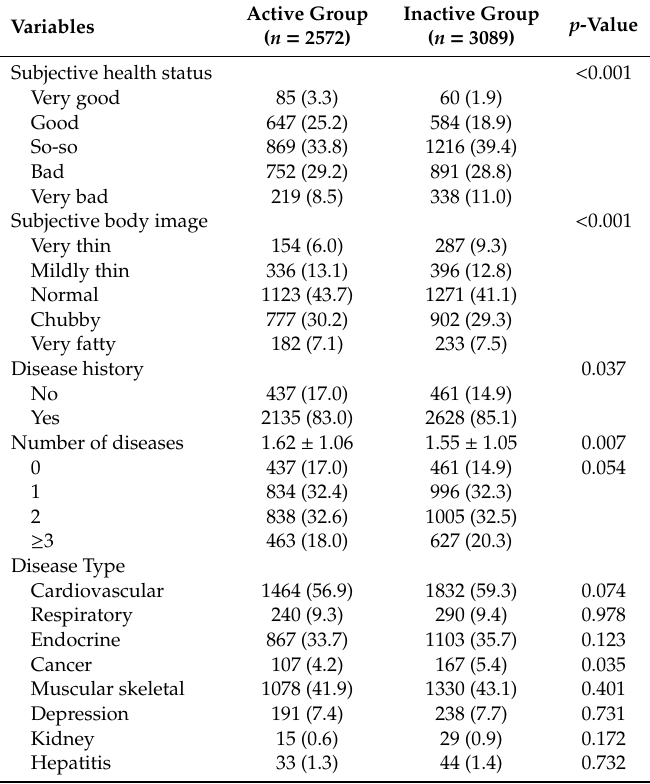
Table 2. Health status according to physical